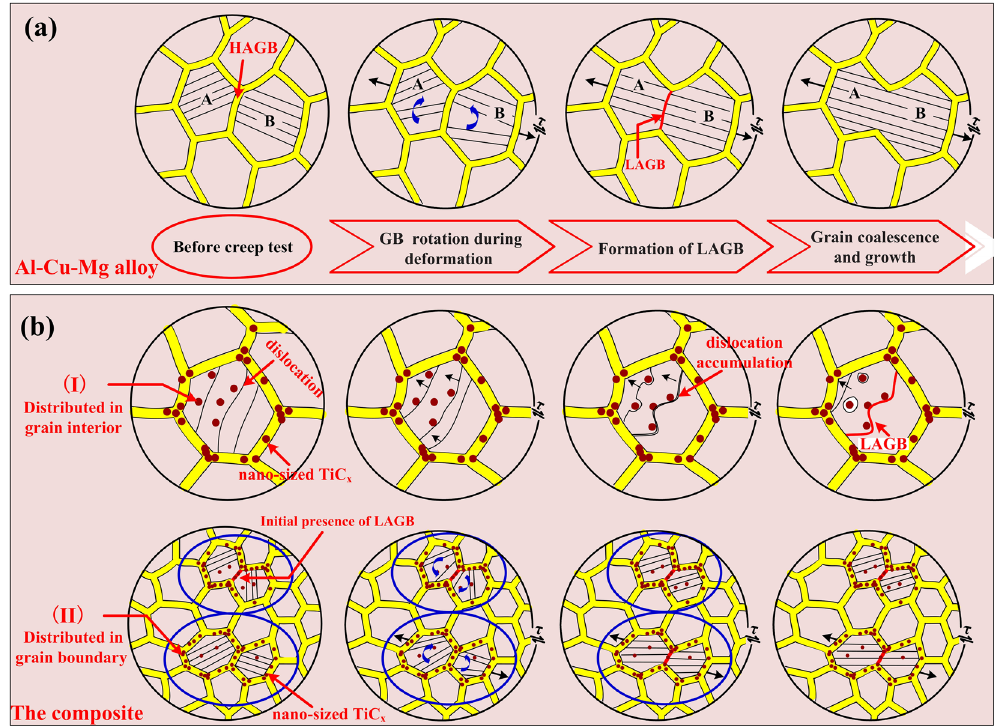
Figure 8. Proposed schematic for deformation model of ( a ) Al-Cu-Mg alloy and ( b ) its